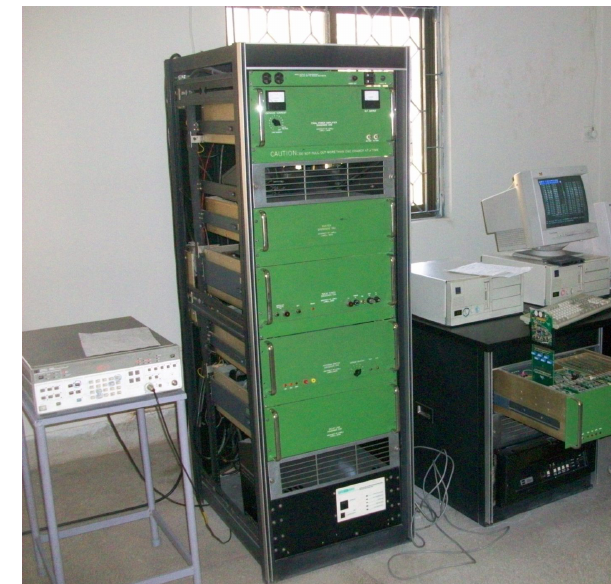
Figure 5. A view of the DGS-256 installed at the Karachi Iono- spheric Station